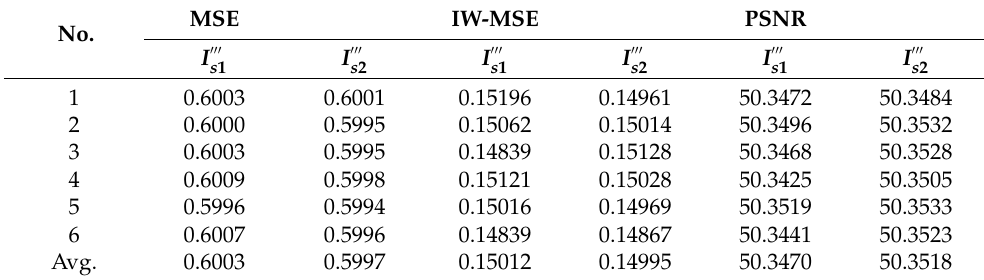
Table 10. Full-reference image quality assessment for six test images (MSE, IW-MSE, PSNR).